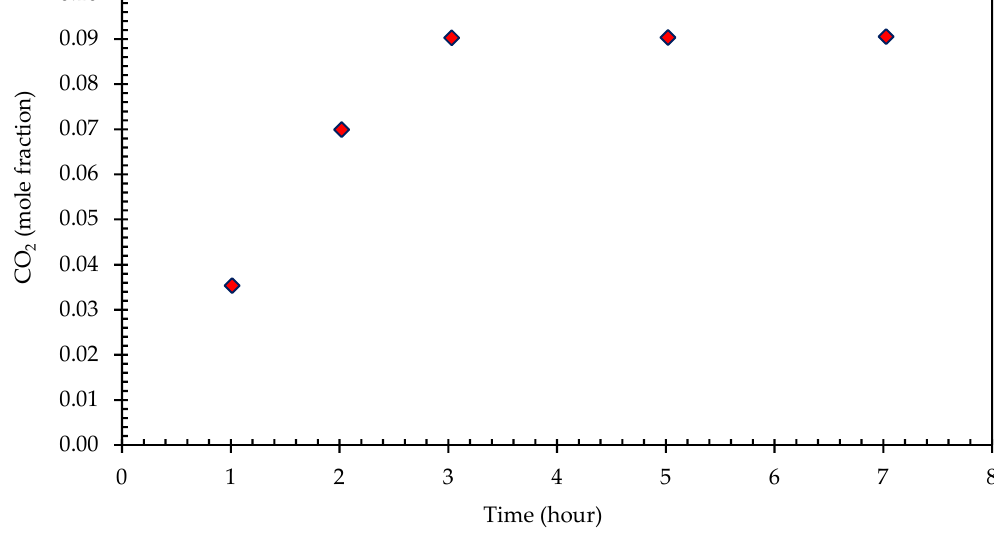
Figure 3. Effect of agitating time on mole fraction of soluble CO 2 (a set of experiments for 1.91 mol/kg-CaCl 2 solution at 351.65 °K and 137.9 Bar).